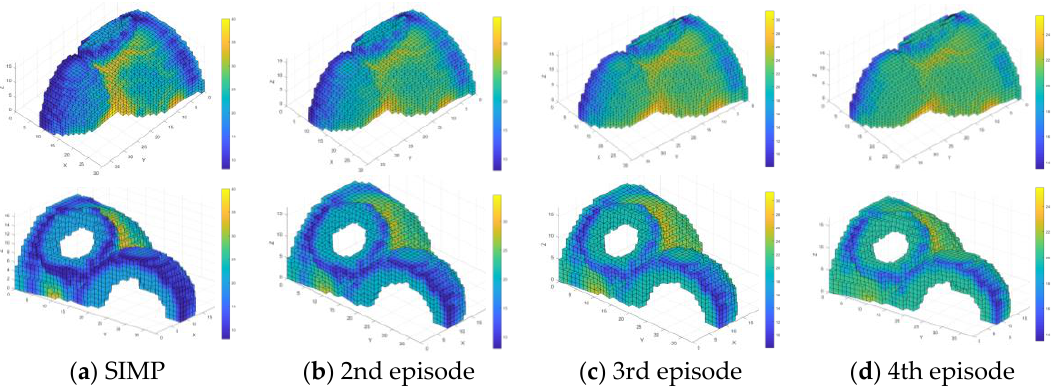
Figure 14. The stress contour of the upper body (before optimization).